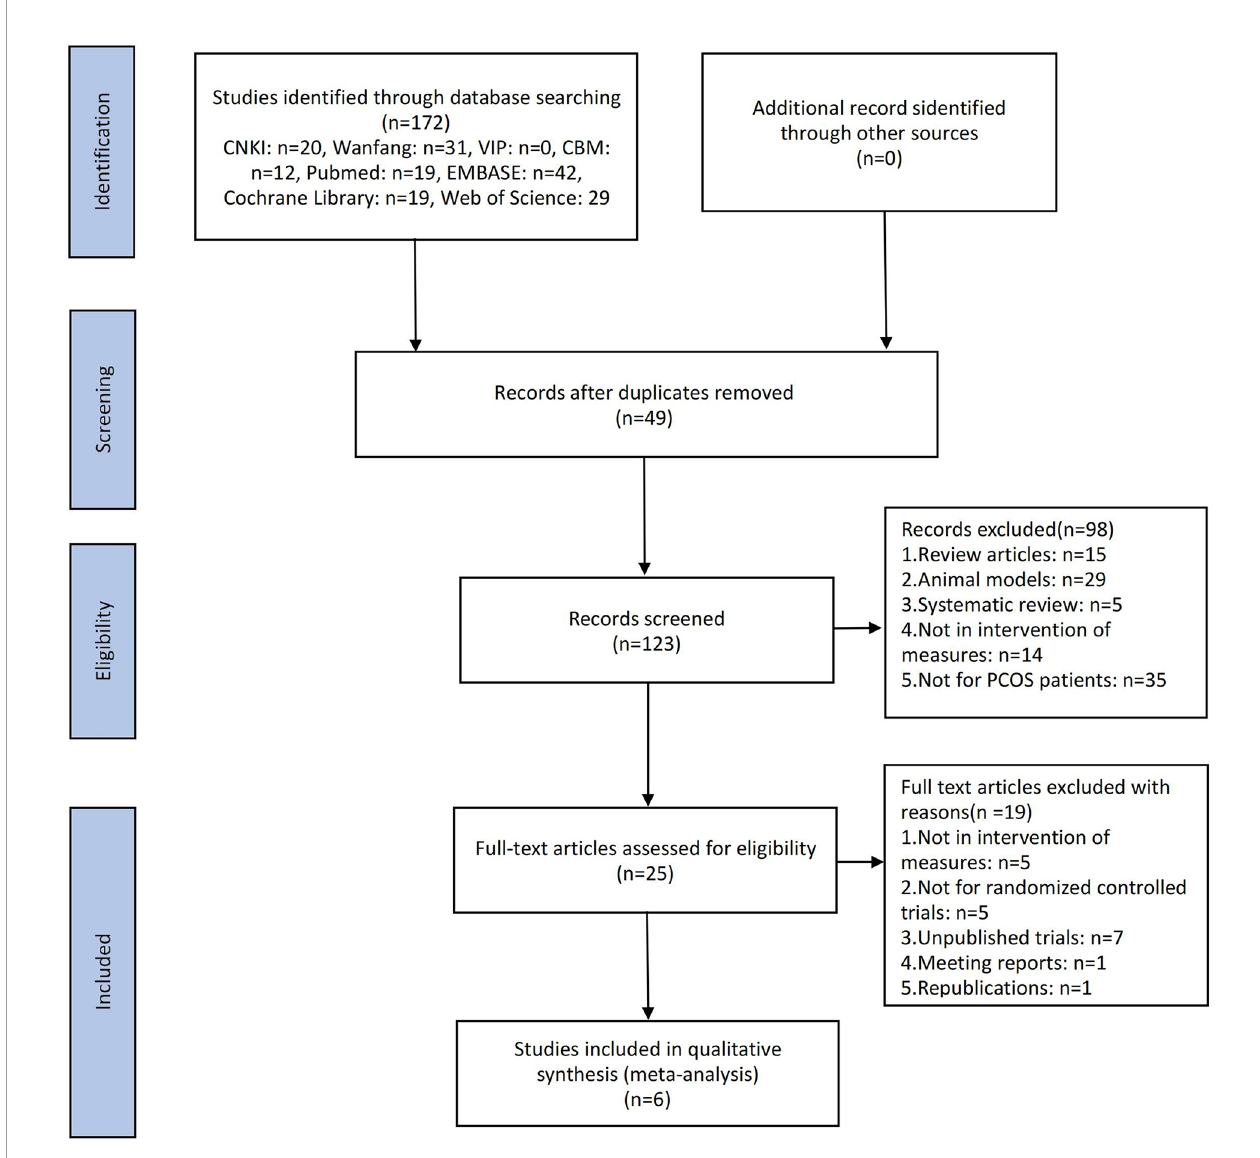
FIGURE 1 | Flow diagram of the study selection